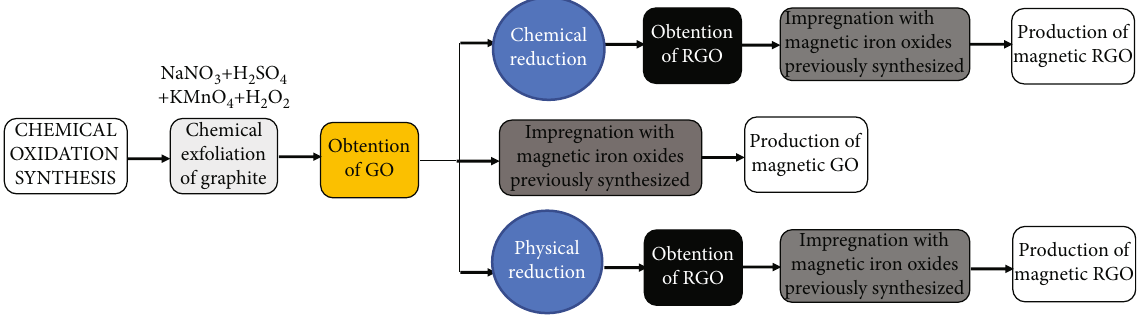
Figure 5: General steps for the preparation of magnetic graphene oxide (GO) and magnetic reduced graphene oxide (RGO) by